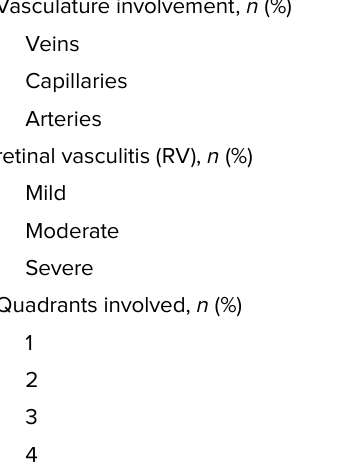
Table 3. Characteristics of retinal vasculitis and uveitis Characteristics of retinal vasculitis eyes (n = 31)